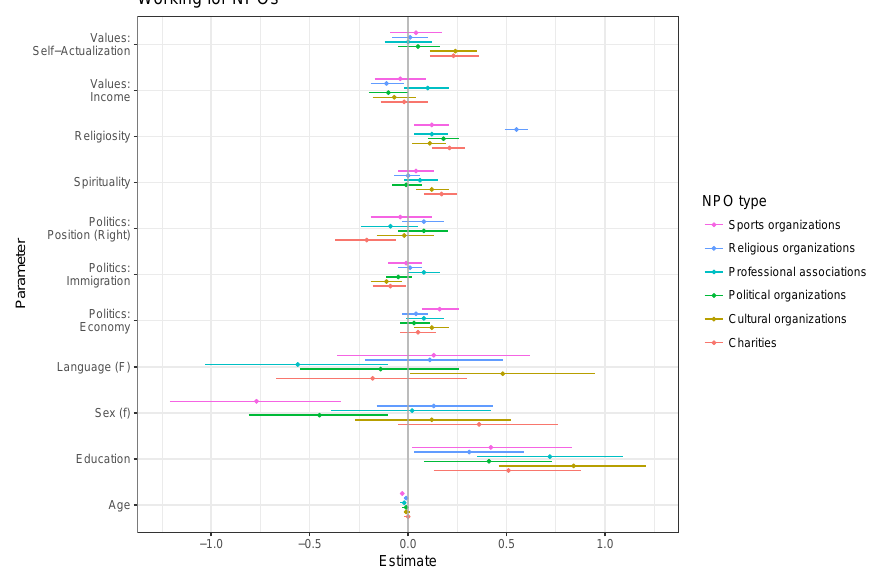
Figure 5. Parameter estimates for the six models with interest in professional work for an NPO as the response (dependent)